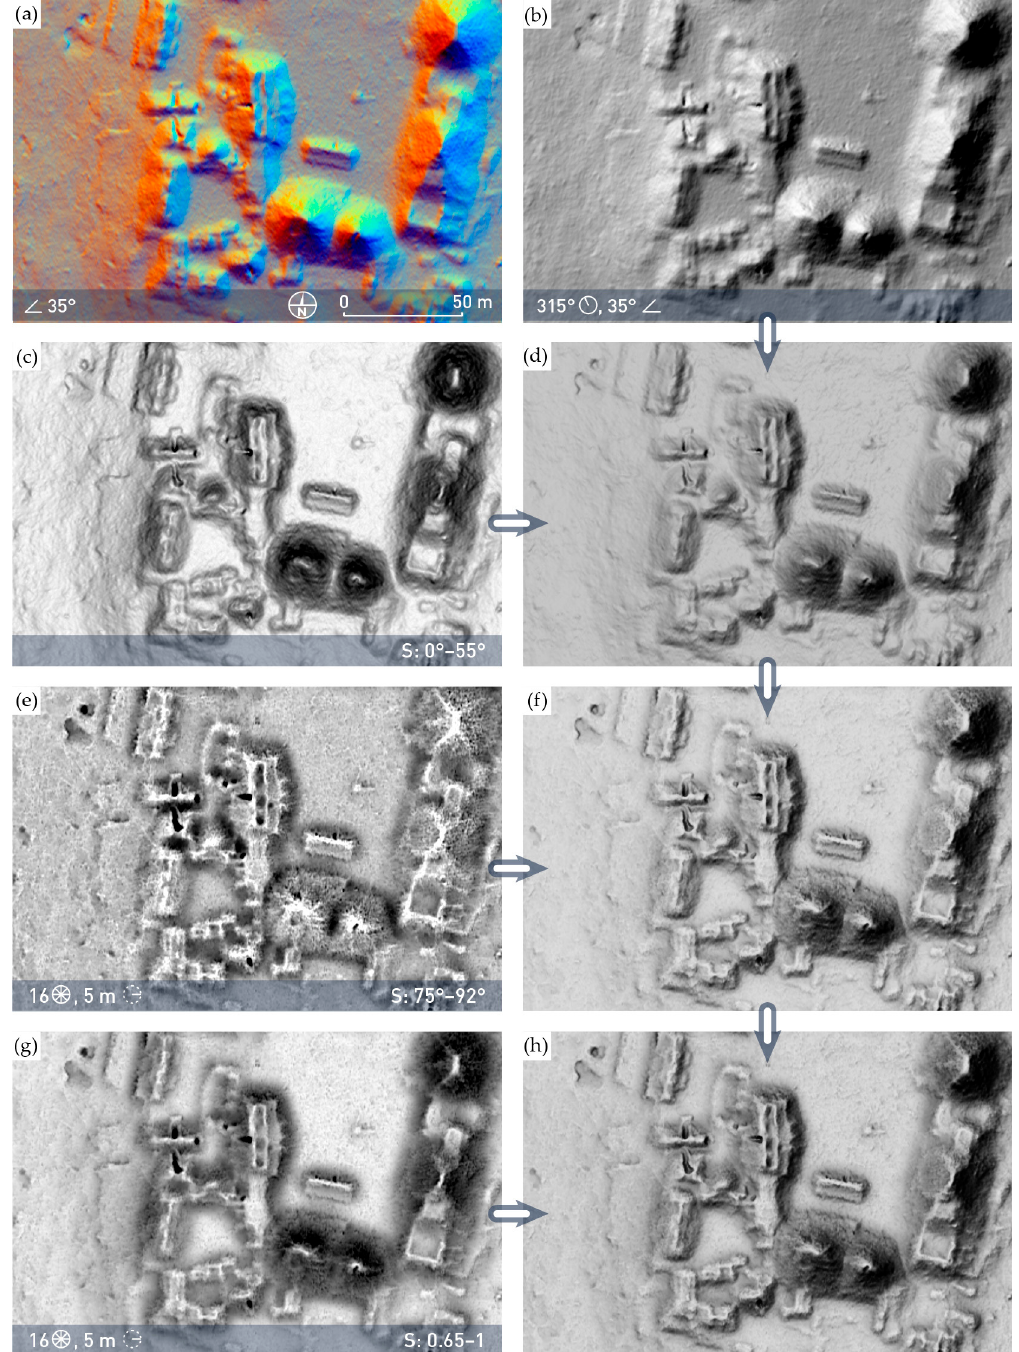
Figure 7. The results of individual steps of building the visualization for archaeological topography. A detail of Chactún south-eastern group is shown with ( a ) an RGB composite of hillshadings from three directions, ( b ) shaded relief, ( c ) slope, ( e ) positive openness, ( g ) sky-view factor. The latter three are consecutively added to (blended with) the (b), ( d ) and ( f ) in the right column to form the final combination ( h ). The (c) blends hillshading with slope using luminosity blend mode with 50% opacity, the (f) adds openness using overlay with 50% opacity, and the (h) adds sky-view factor using multiply with 25% opacity. The result of combining (a) as a base layer is shown in Figure 9d.